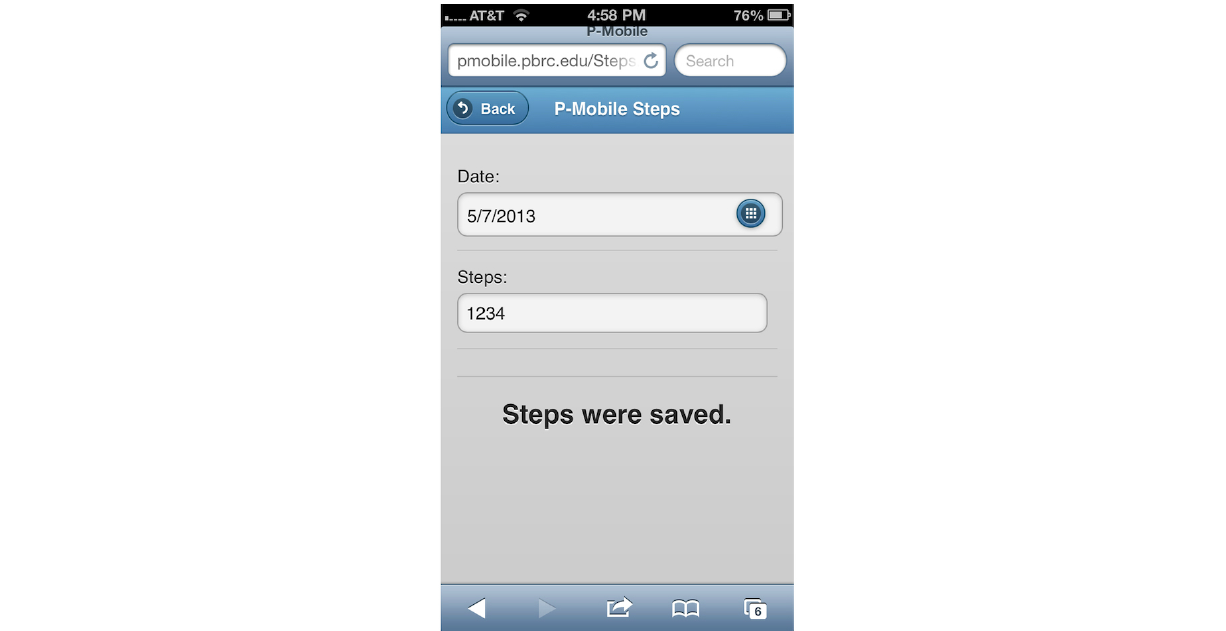
Figure 2. Mobile phone screenshot showing pedometer step count entry on P-Mobile